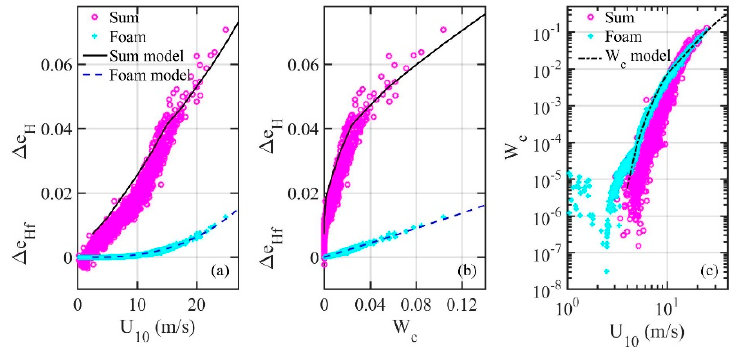
Figure 2. Illustration of whitecap retrieval using ∆ e p . WindSat 6.8 GHz horizontal polarization data are used for example ( p = H ): ( a ) ∆ e H ( U 10 ) and ∆ e Hf ( U 10 ), ( b ) ∆ e H ( W c ) and ∆ e Hf ( W c ), ( c ) W c ( U 10 ) retrieved with ∆ e H and ∆ e Hf . Reproducing part of ([21], Figure 2).